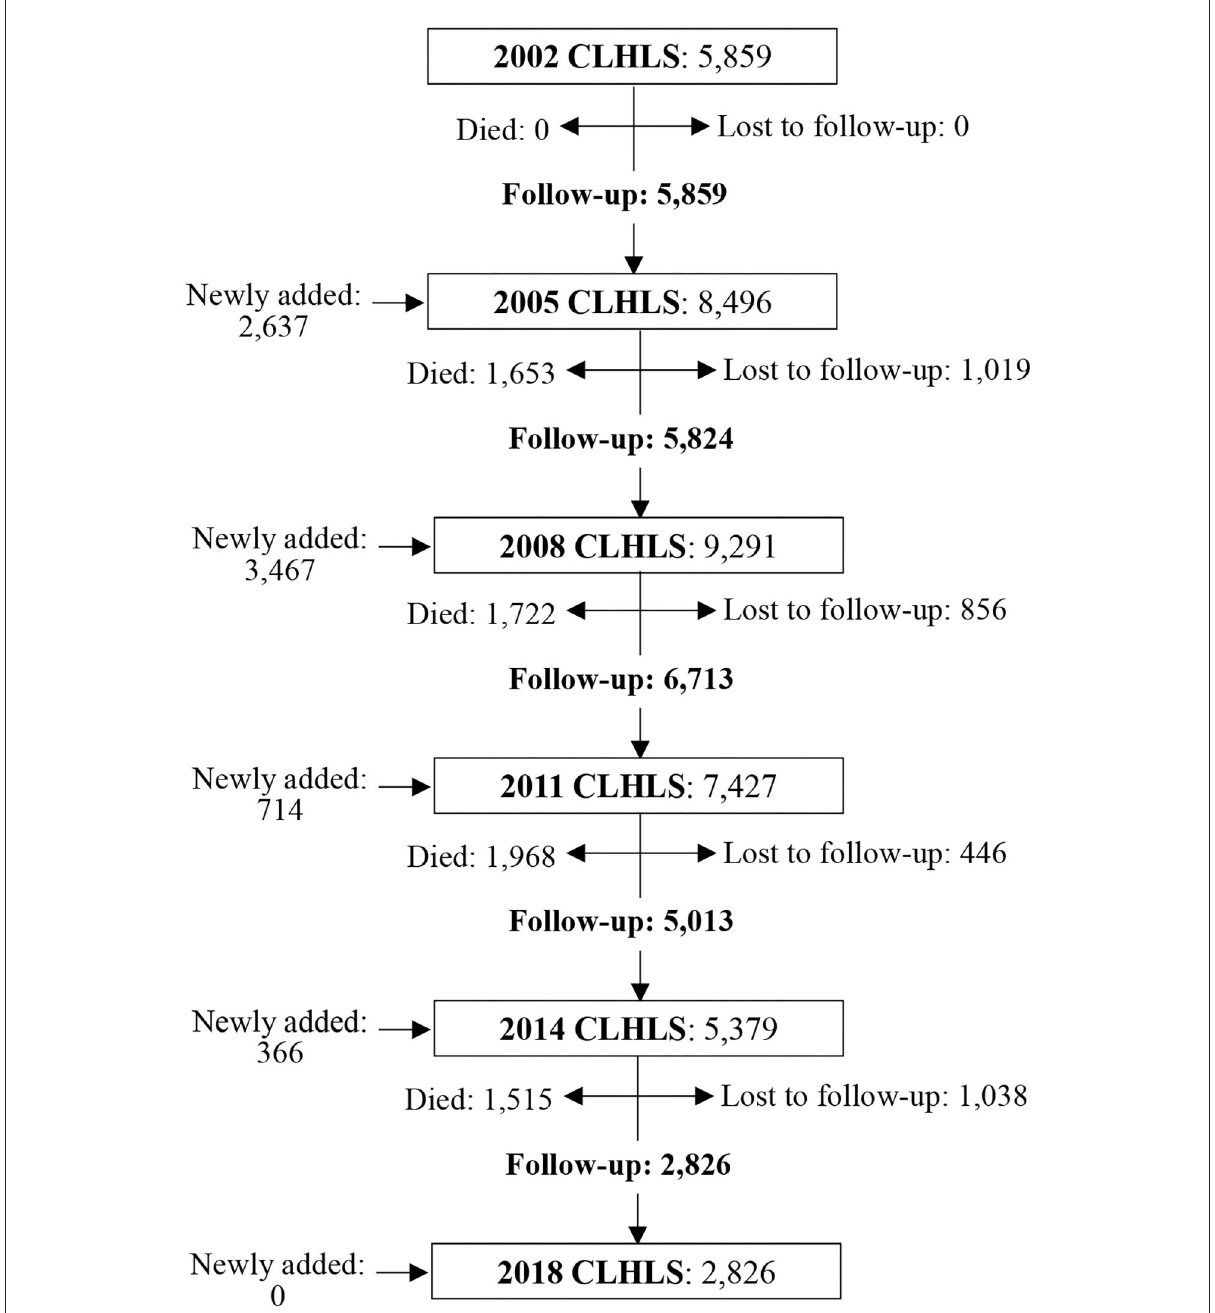
FIGURE1 Flow chart of sample size across 6 waves of the CLHLS from 2002 to 2018. All the samples kept in the study were surveyed for at least two waves. Those samples who were surveyed only in one wave were removed.